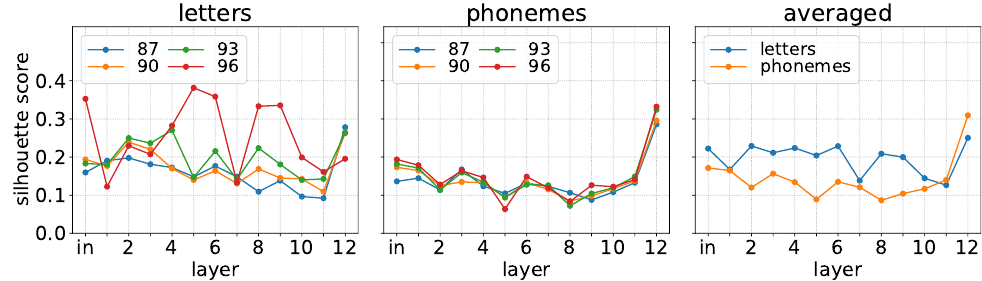
Figure 8. Silhouette scores at different distance thresholds, derived from SNAP clustering in the W2L model comparing grouping by predicted letters and by phoneme